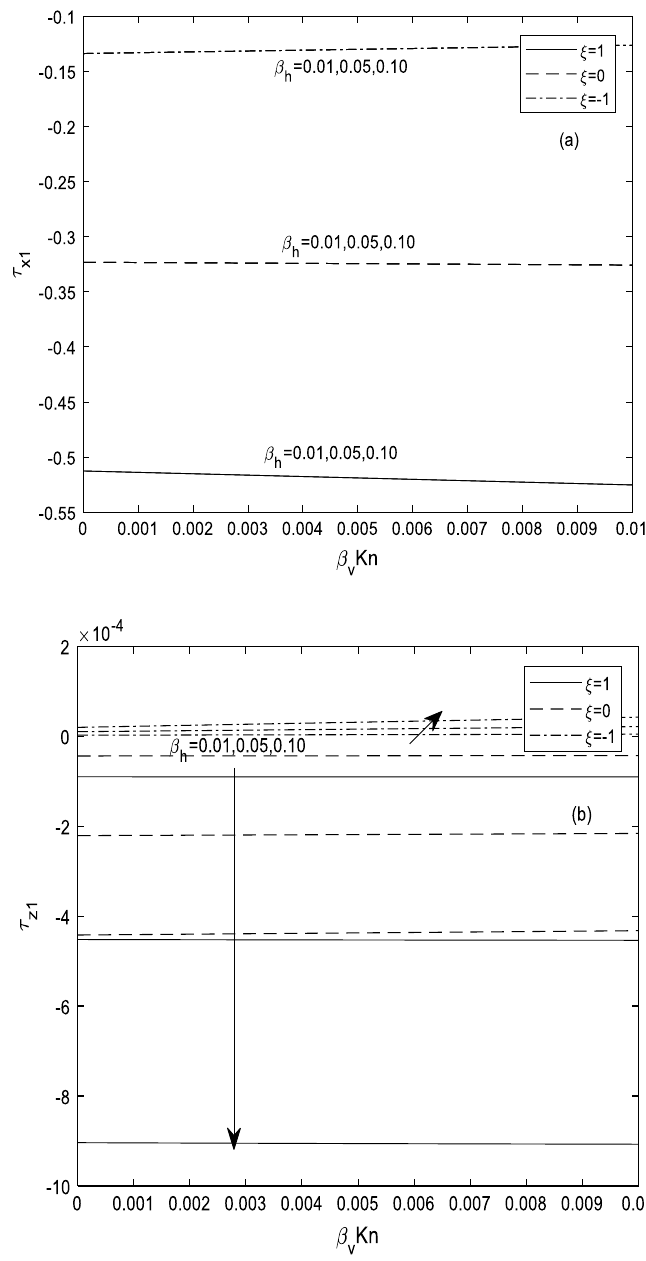
v Kn = 0.05, M = 2,ln = 1.667, M = 2.0, β i = 3.0 and Pr = 0.71 . b Hall current ( β h ) on the main flow and induced skin friction profiles at y = 1 , for β